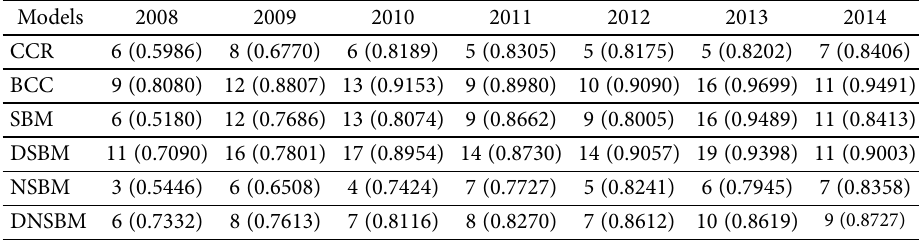
Table 8. Comparison of efficiency scores between traditional and SBM models Models